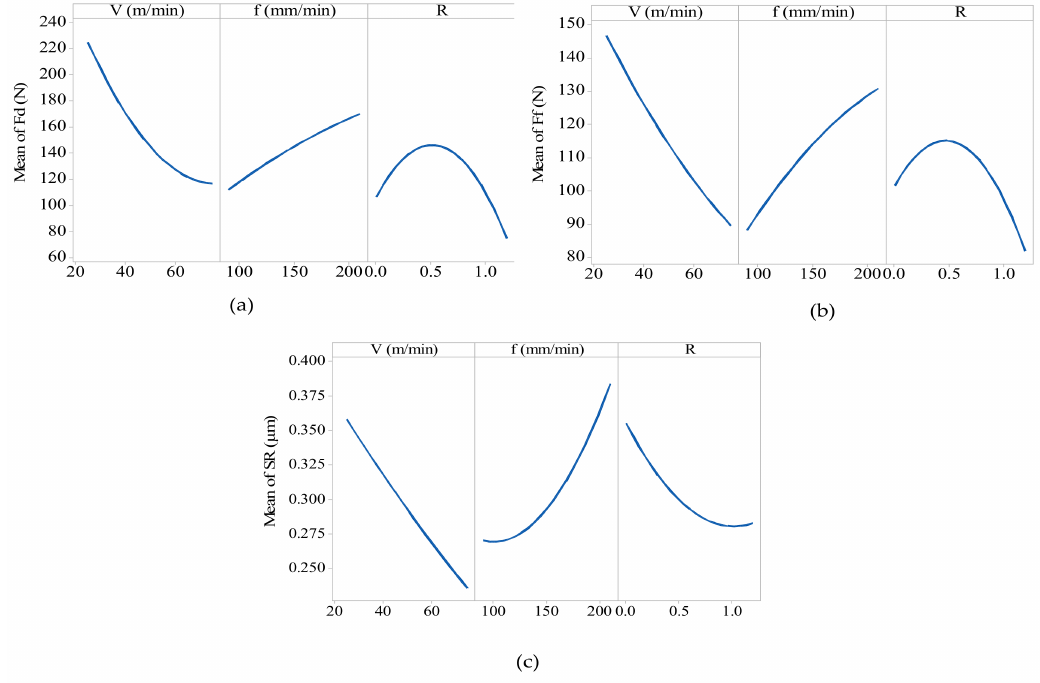
Figure 5. E ff ects of the milling parameters and GNPs reinforcement ratio on the ( a ) depth force ( b ) feed force and ( c ) surface